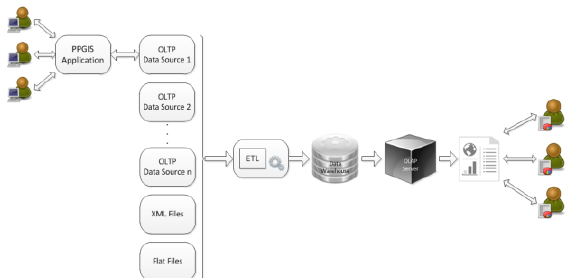
Figure 2. Architecture of the developed system for